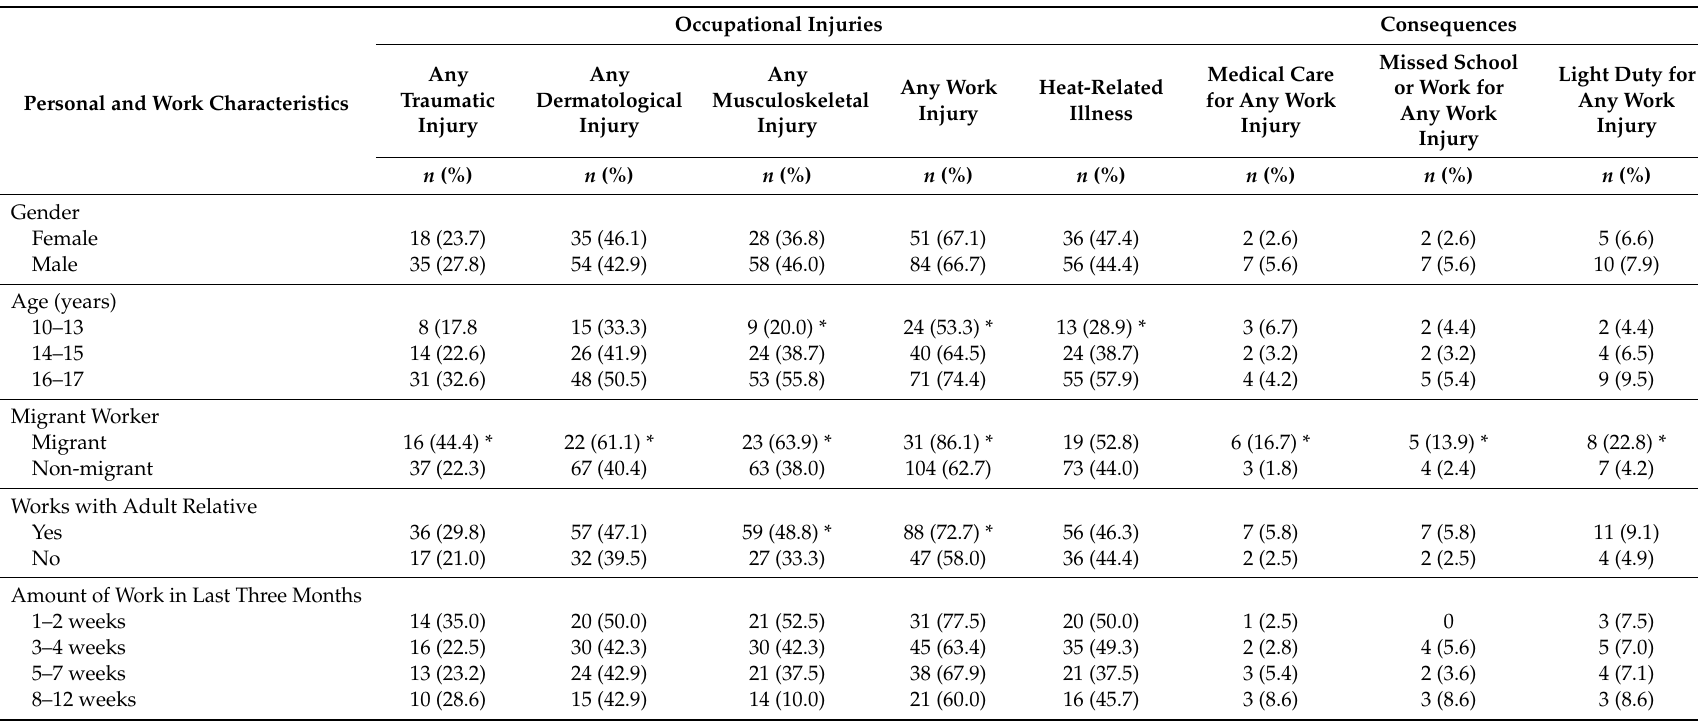
Table 6. Association of personal and work characteristics with occupational injuries in the past year for North Carolina Latinx child farmworkers, 2017.